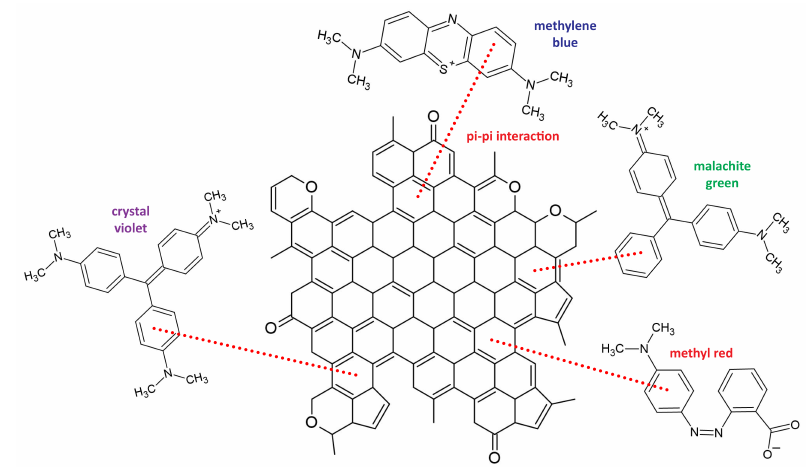
Figure 7. Organic dyes adsorption on activated carbons.